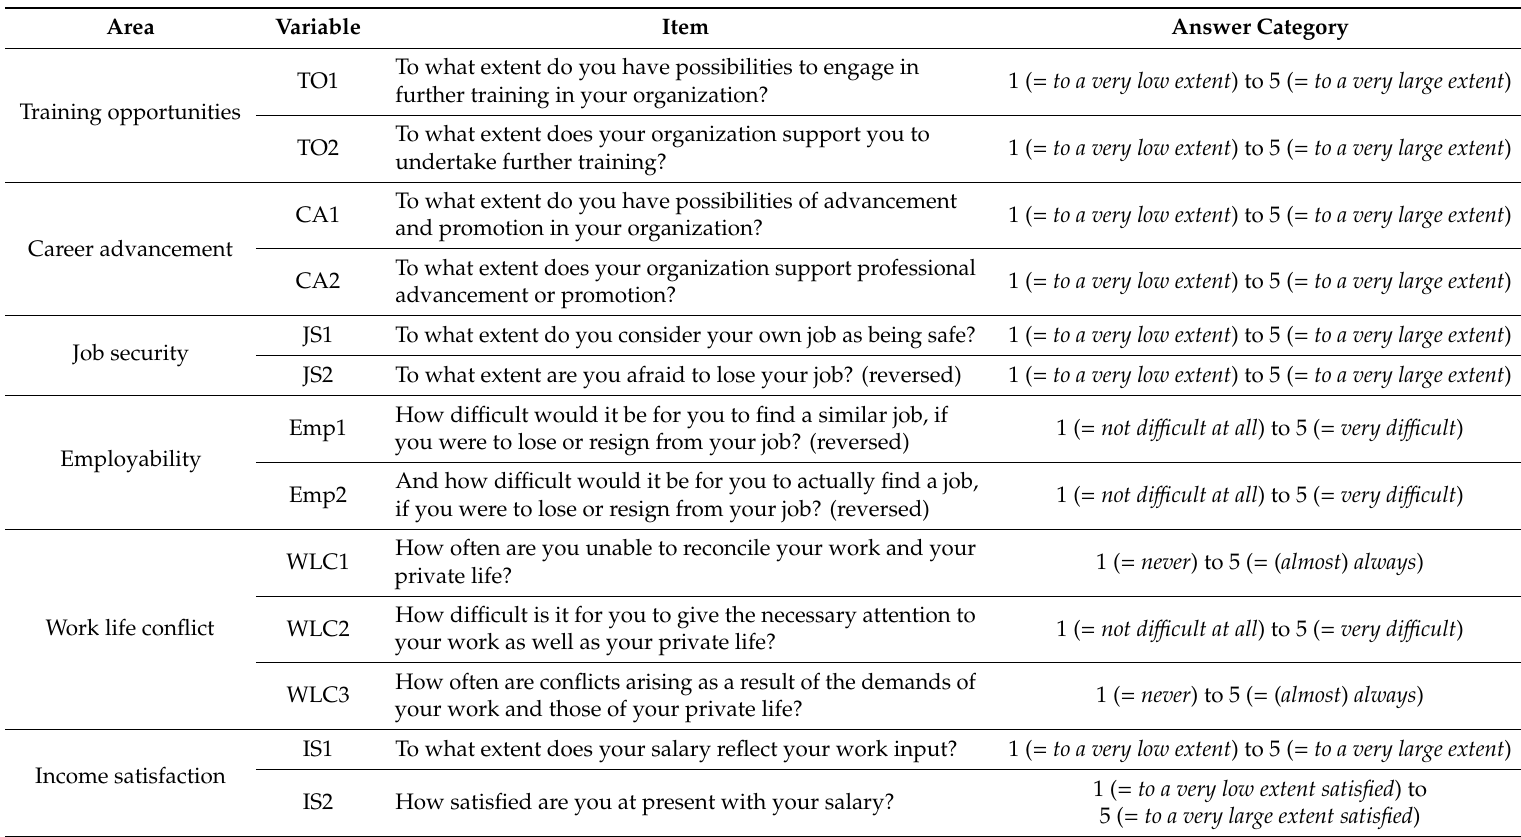
Table A2. Quality of Employment